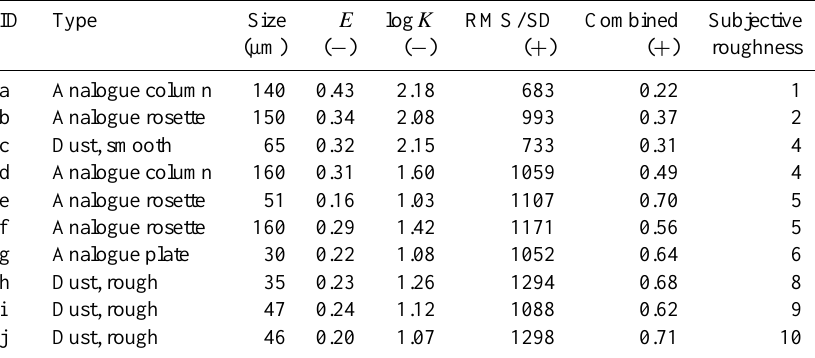
Table 3. Ice analogue and mineral dust test particles in increasing order of subjective roughness (see Sect. 2). The size is the approximate maximum dimension. The roughness measures are GLCM energy E , log kurtosis log K , RMS/SD and “combined roughness” (see text); the signs in brackets indicate the sign of correlation with